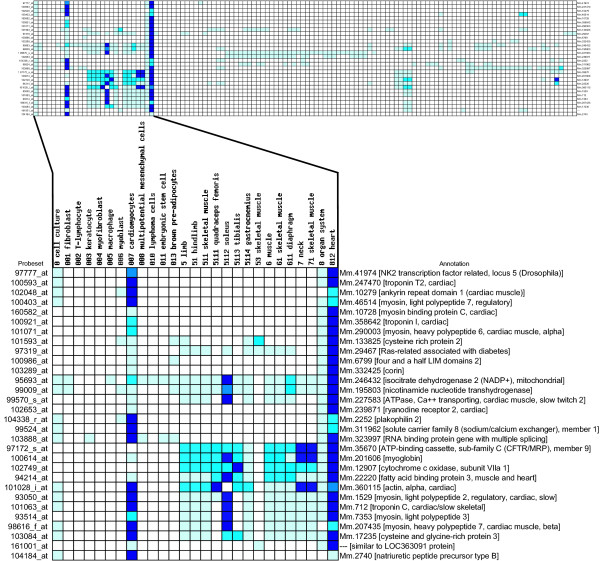
Identification of marker genes. Hierarchical cluster of the top 30 genes preferentially or specifically expressed in the heart. Results were calculated from 2138 arrays of type MG-U74Av2 (12 K).